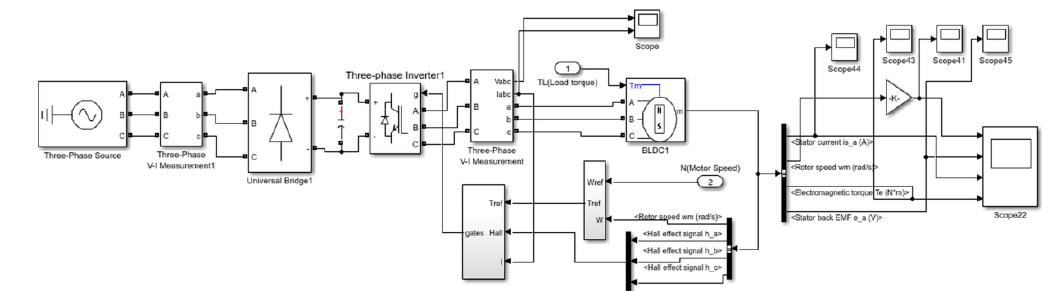
Figure 8. MATLAB/Simulink model of steel rolling process. Figure 8. MATLAB / Simulink model of steel rolling process. Electronics 2020 , 8 , x FOR PEER REVIEW